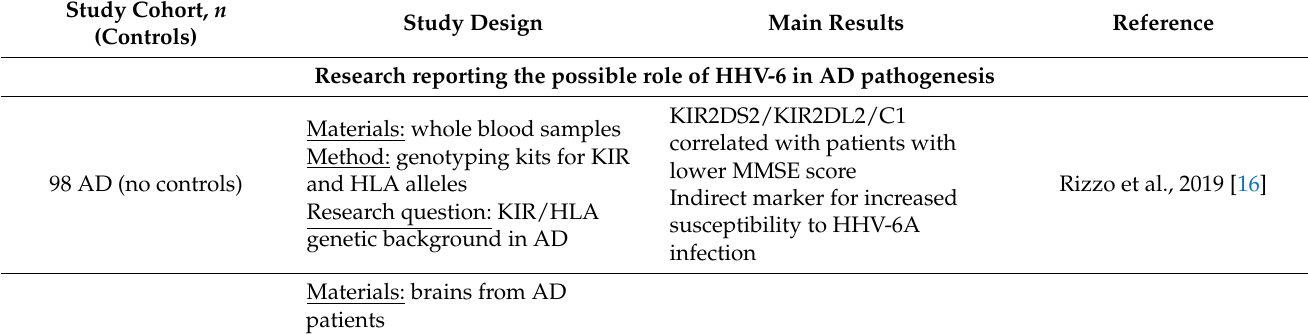
Table 2. The most relevant research on the HHV-6 infection—AD association—pro vs. contra studies. Study Cohort,